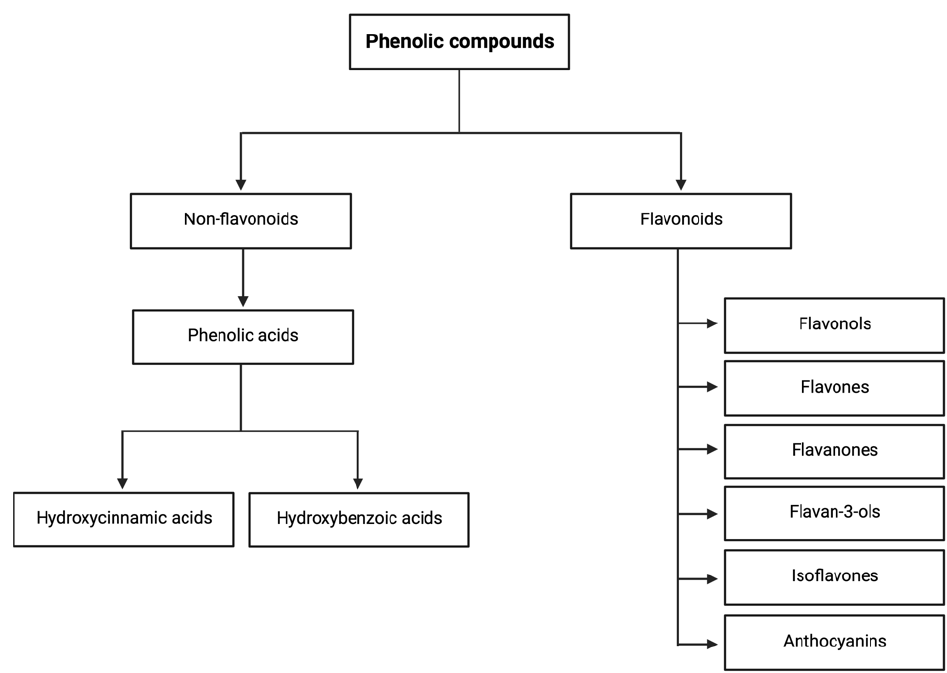
Figure 1. Chemical classification of the main phenolic compounds found in Prunus avium L. Based mainly on high-performance liquid chromatography coupled to diode array detection and electrospray ionization/ion trap mass spectrometry (HPLC-DAD-ESI/MS n ), high-performance liquid chromatography-diode array detection (HPLC-DAD), and gas chromatography–mass spectrometry (GC-MS) separation techniques, several